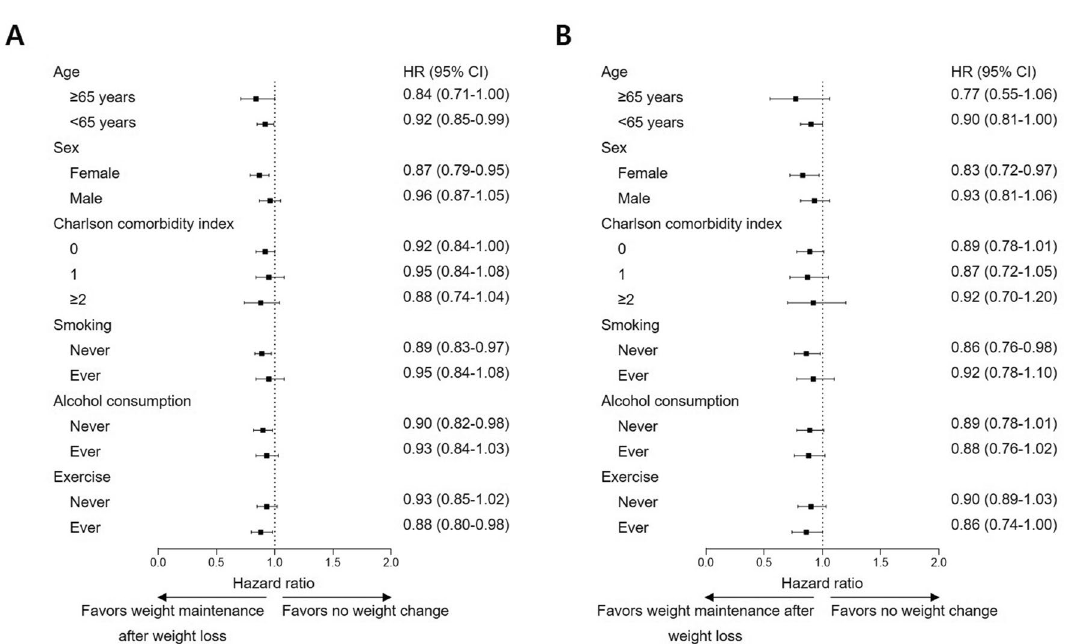
Figure 3. Subgroup analyses on cardiovascular risks of weight maintenance after weight loss compared to no weight change. ( A ) Cardiovascular disease. ( B ) Coronary heart